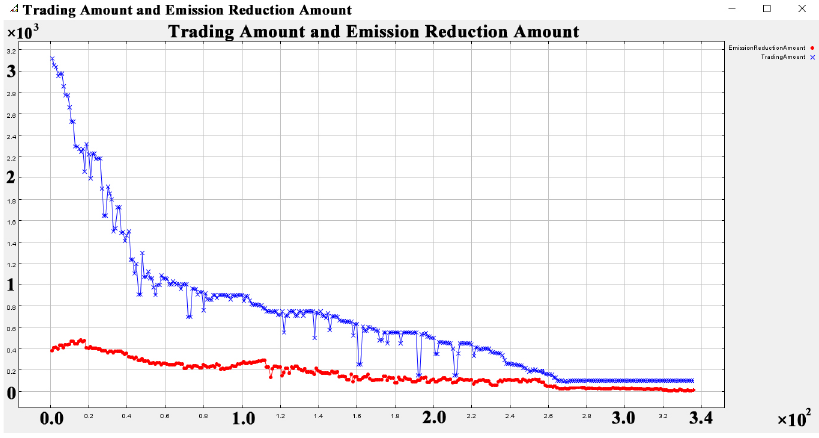
Figure 9. Quota purchase amount and emission reduction curve by step – private chain